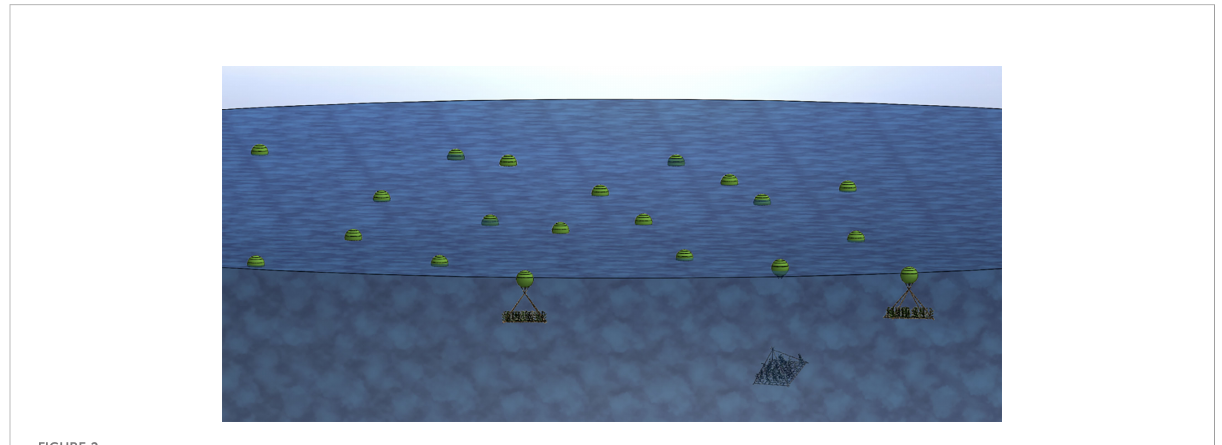
FIGURE 2 Free fl oating raft concept